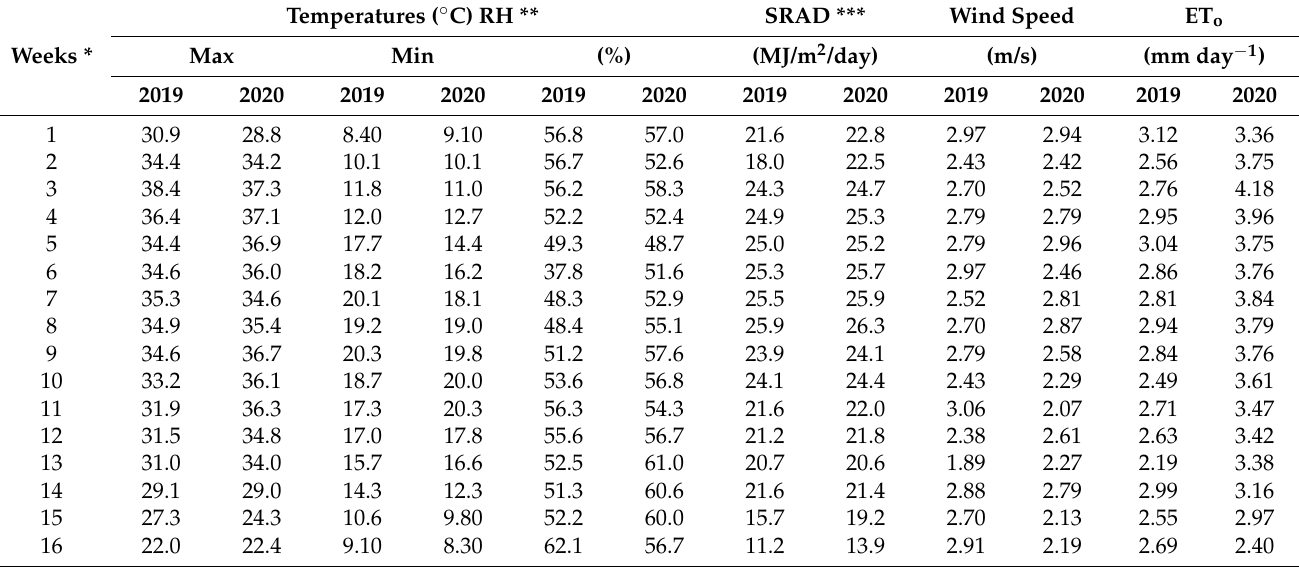
Table 1. Means of climatic parameters and reference evapotranspiration (ET o ) during green bean growth and development at experimental site (during 2019 and 2020 season).